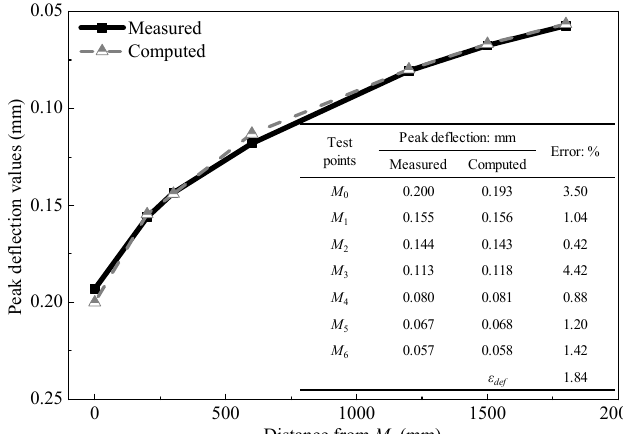
Figure 4. Comparison of measured and computed peak deflection values at different test points.